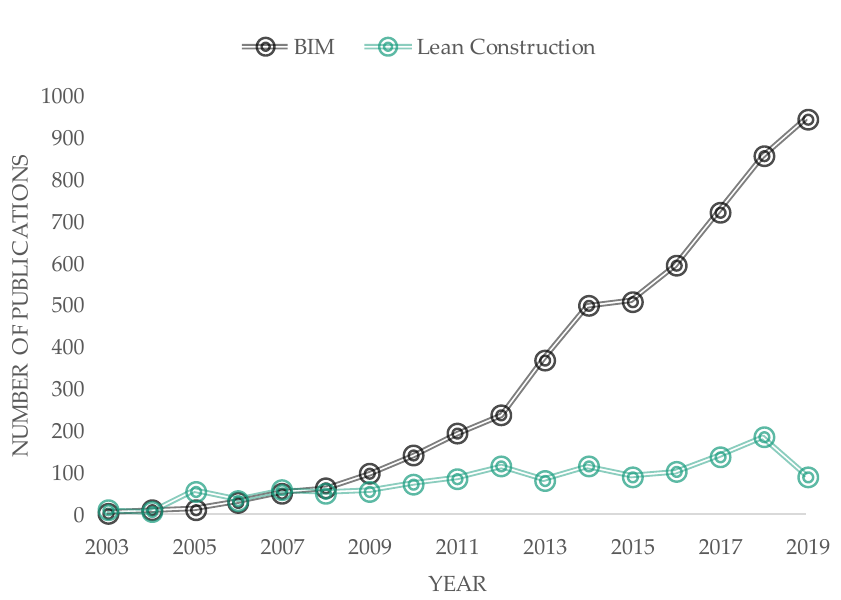
Figure 1. Building information modeling (BIM) / Lean construction papers published: 2003–2019; (data retrieved from the Scopus Database; search terms TITLE-ABS-KEY ((“building information modeling” or “building information modelling”))” and (“lean construction”))).